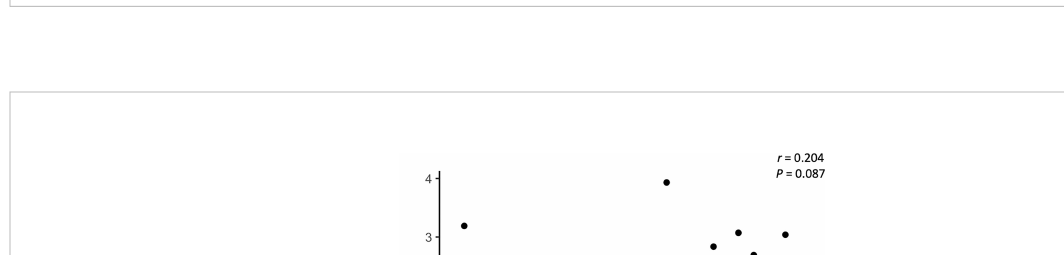
FIGURE 1 Differences in circulating GDF15 and ACE2 levels in COVID-19 patients and a uninfected control group. (A) GDF15 levels; (B) ACE2 levels; (C) ratio GDf15/ACE2; The box plots represent the maximum and minimum levels (whiskers), the upper and lower quartiles, and the median. The length of each box represents the interquartile range. Dots represent outliers. Statistical signi fi cance between groups was determined using the ANOVA test. **p <0.001, # p <0.001 UCI vs Control, n/s (non signi fi cant); GDF15 (Growth differentiation factor 15); ACE2 (angiotensin-converting enzyme 2).